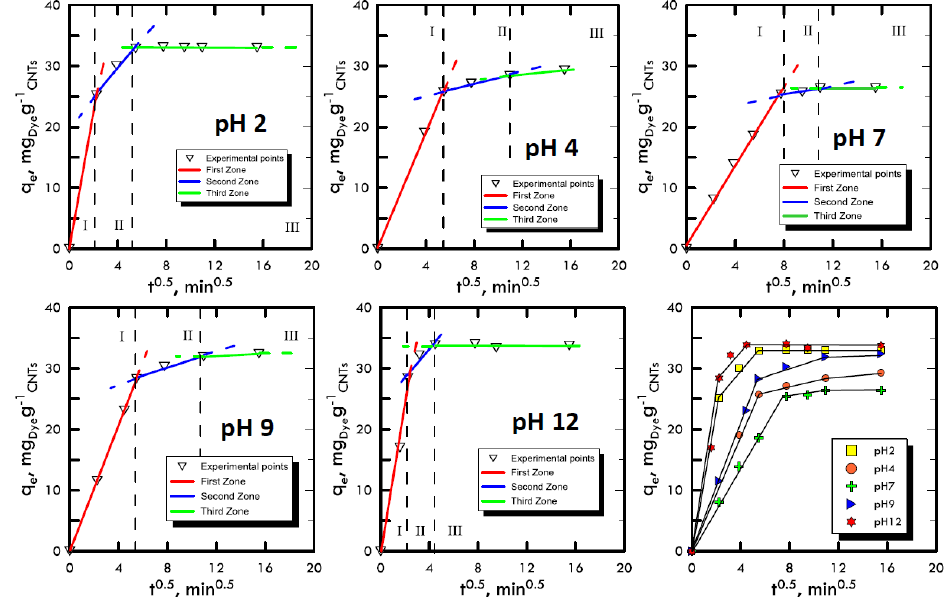
Figure 2. Weber and Morris method for the analysis of the transport mechanism RB-116 at different pH values. Table 1. Return of Weber and Morris models for Reactive Blue 116.